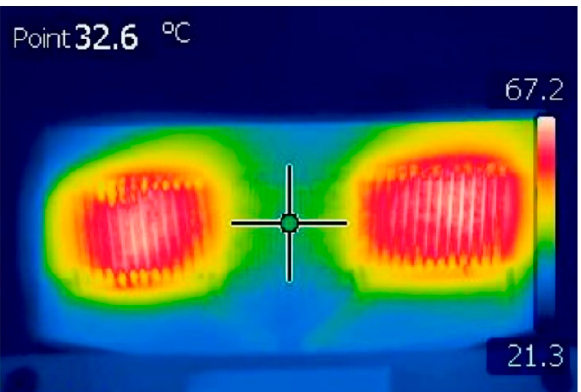
Figure 17. The temperature distribution of the printed fluxgate magnetometer under a certain working condition.